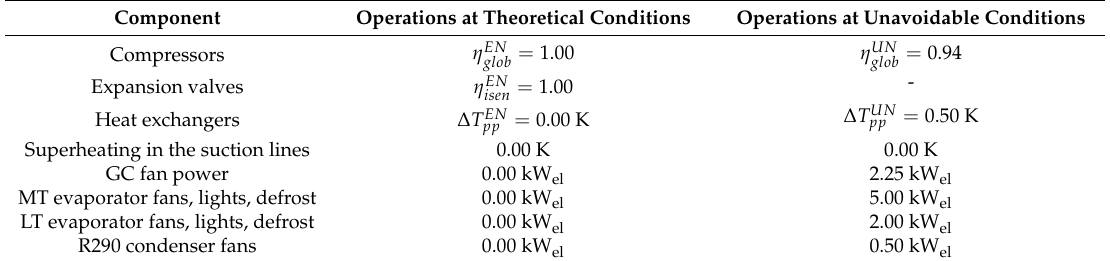
Table 6. Assumptions made to implement the advanced exergy analysis